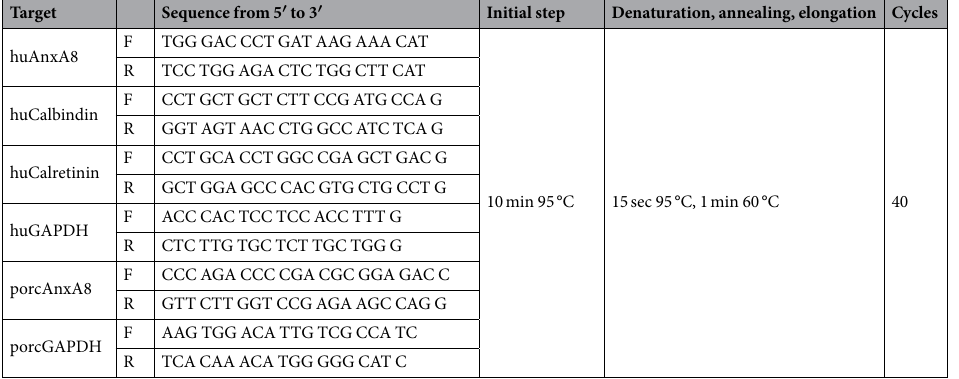
antibody (1:200, Invitrogen) and rhodamine phalloidin (1:200, Invitrogen) were added for 1 h. Nuclei were stained with DAPI (1:1000, Sigma). As a negative control, the primary antibody was omitted. Cells were then mounted in moviol (Calbiochem), and analysed using confocal microscopy (Leica TCS SP2, LSM Zeiss 710). Images were processed in ImageJ (NIH freeware). Real-time PCR.